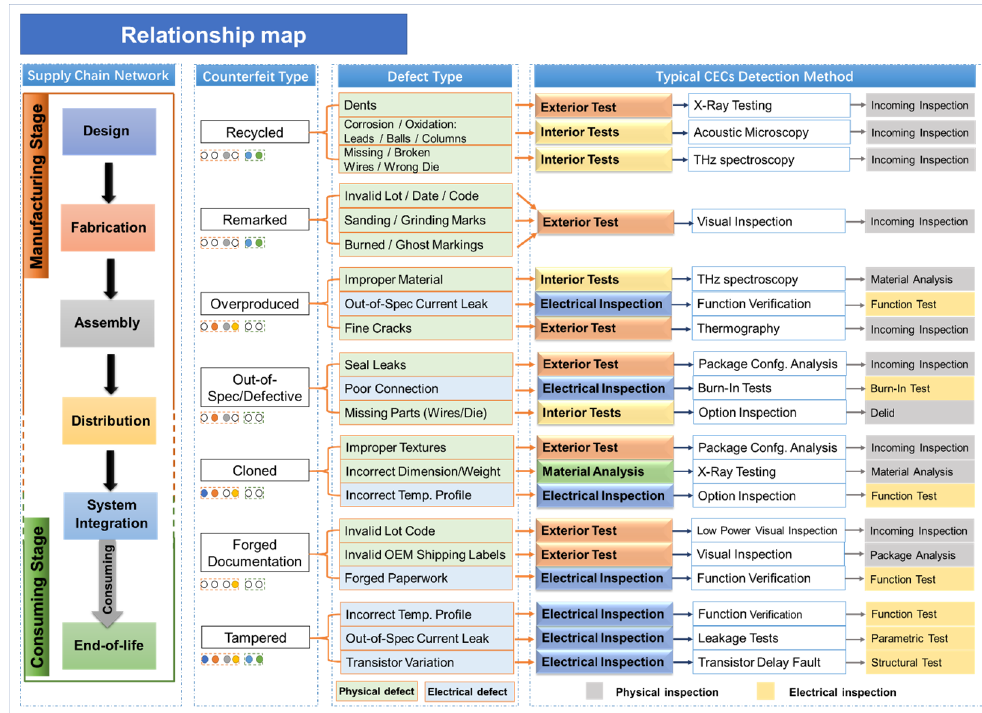
Figure 1. UVEC types and detection methods in the supply chain.